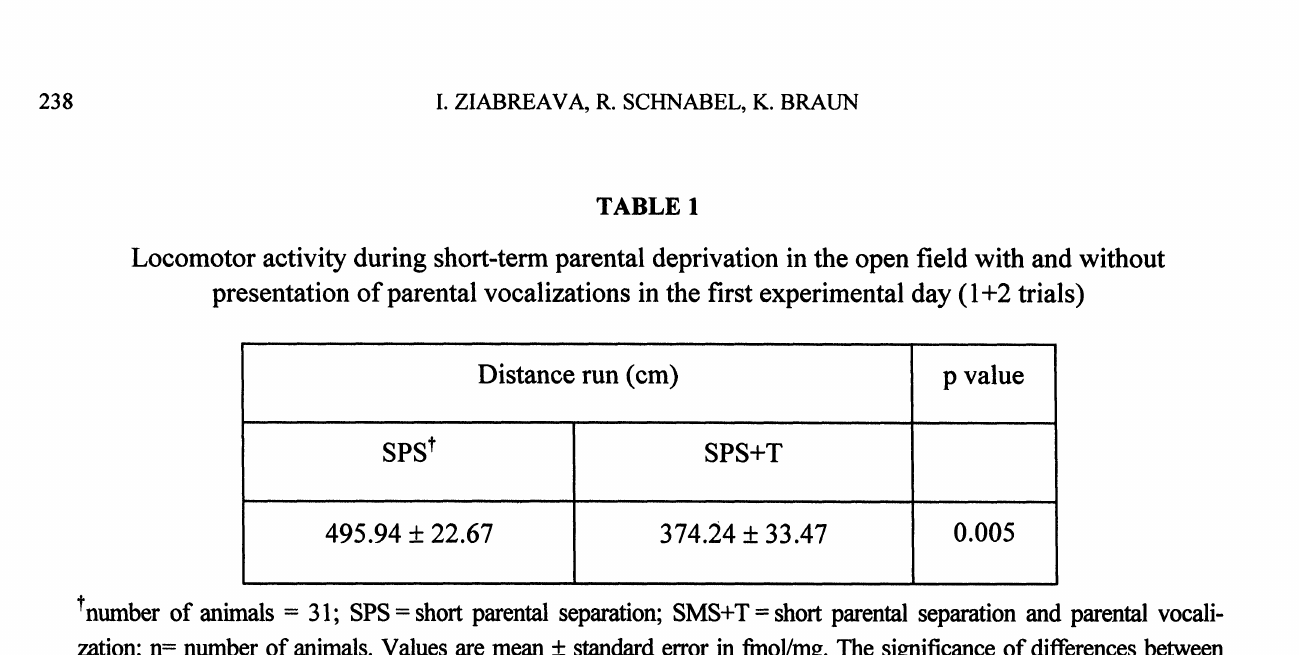
Locomotor activity during short-term parental deprivation in the open field with and